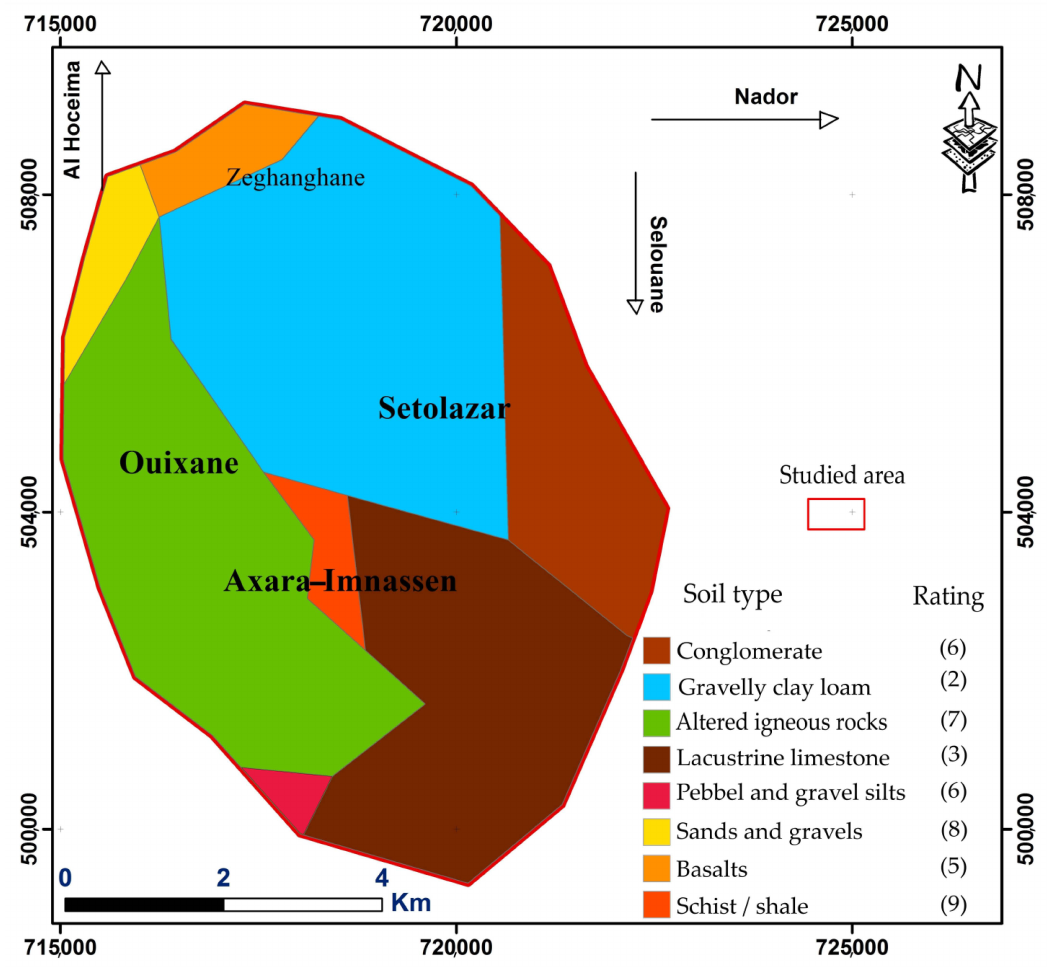
Figure 9. Vadose zone map (unsaturated zone) and attributed rating values.